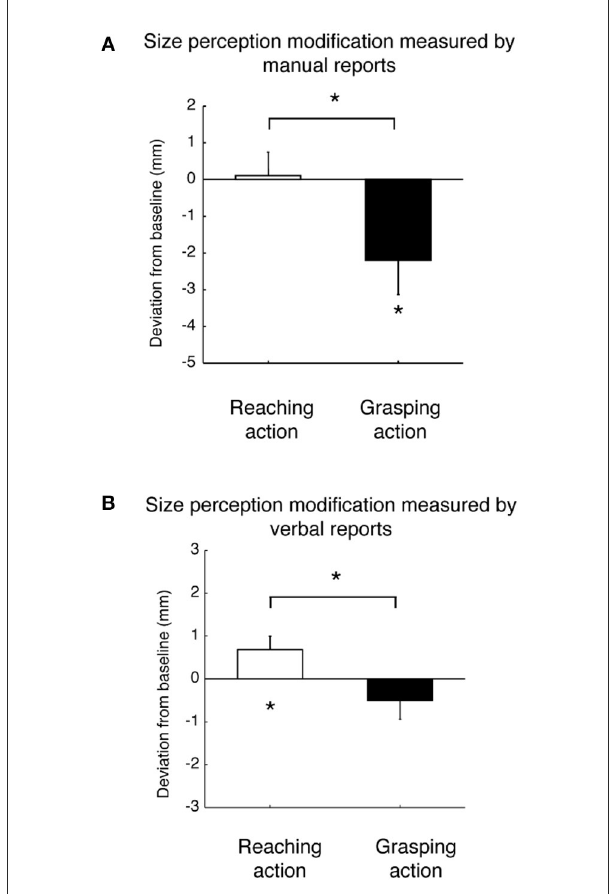
FIGURE6 Size perception modification after reaching and grasping actions. (A) Mean deviation of perceptual responses by grip aperture for reaching (white column) and grasping (black column). (B) Mean deviation of verbal perceptual reports for reaching (white column) and grasping (black column). All data are averaged across participants and sizes. Error bars are standard errors of the mean. * p < 0.05, significance level (modified from Bosco et al.,